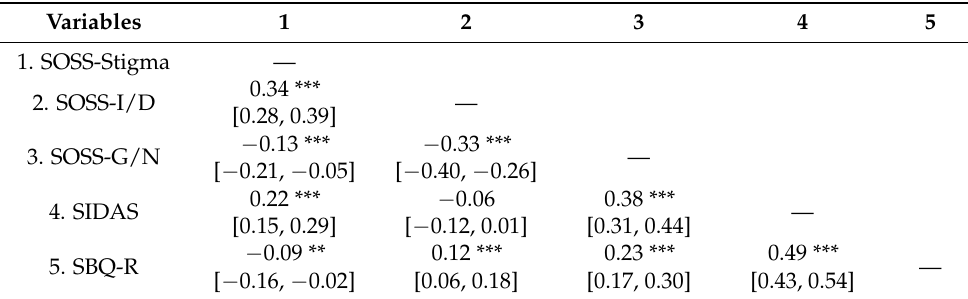
Table 3. Intercorrelations of the Scores on SOSS, SIDAS, and SBQ-R.